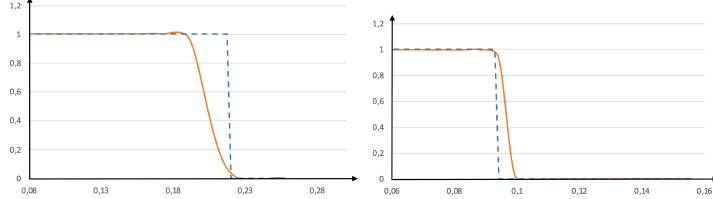
Figure 4. Comparisons P 3 – P 4 (left) and P 2 – P 4 (right) for the Runge function with α = 2000. Statistical frequencies (full) and probabilistic law (2.5) (dotted). 500 meshes are used for each value of h